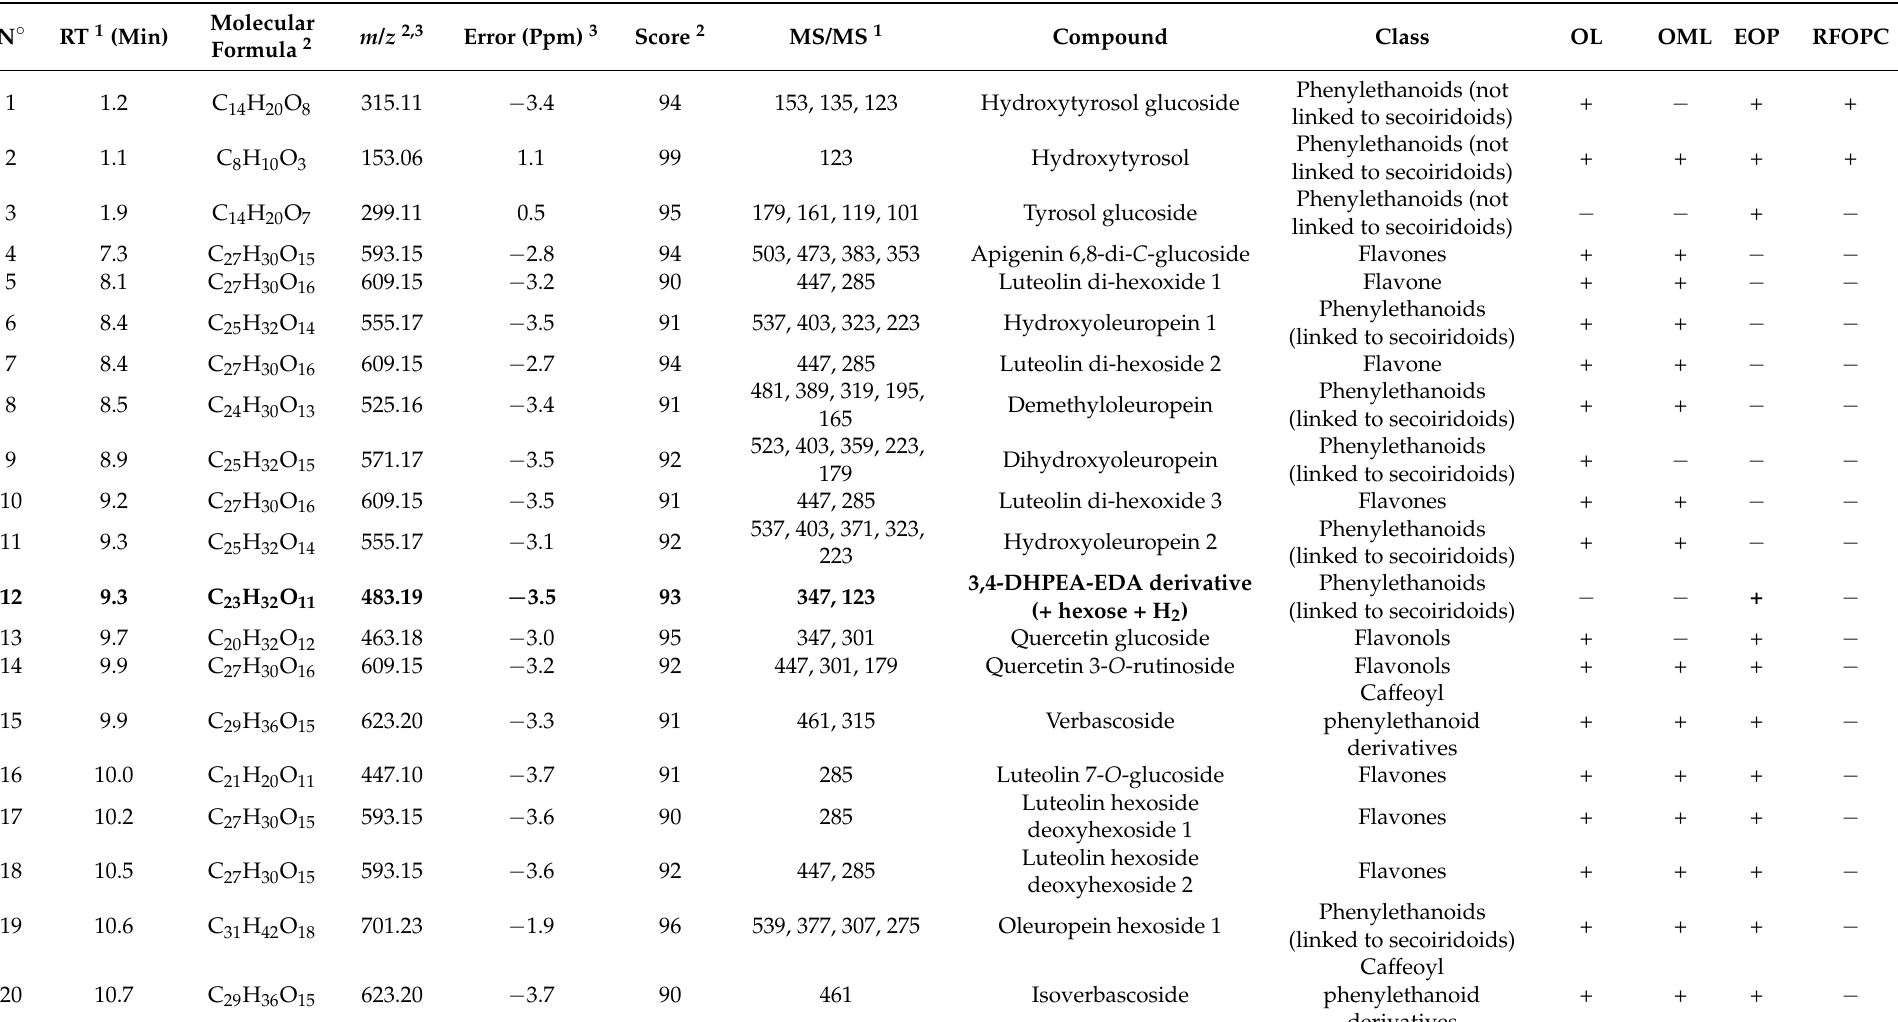
Table 3. Phenolic compounds characterized in olive leaves (OL), olive mill leaves (OML), exhausted olive pomace (EOP), and residual fraction from olive pit cleaning (RFOPC). N